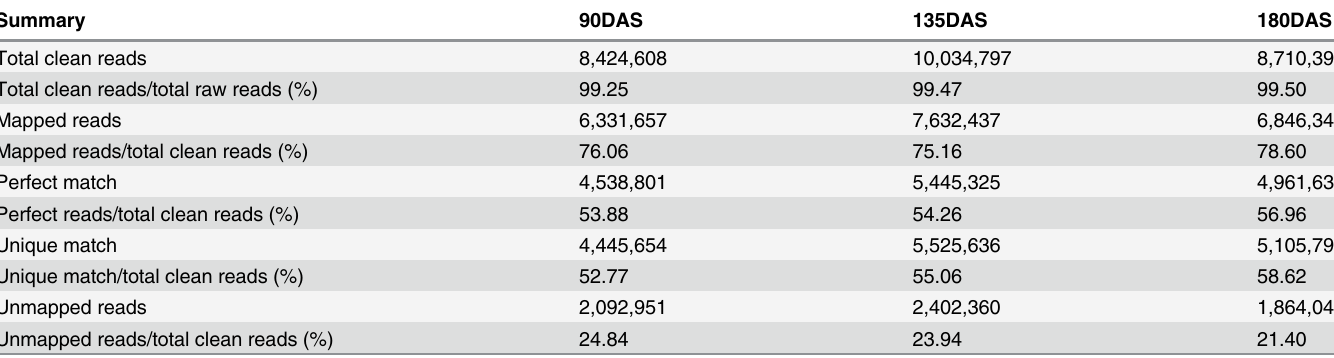
Table 3. Summary of read numbers in the RNA-Seq data from American ginseng seeds.